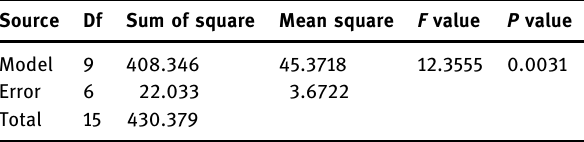
Table 5: Analysis of variance for the regression model ( R 2 = 0.9488 ) Source Df Sum of square Mean square F value